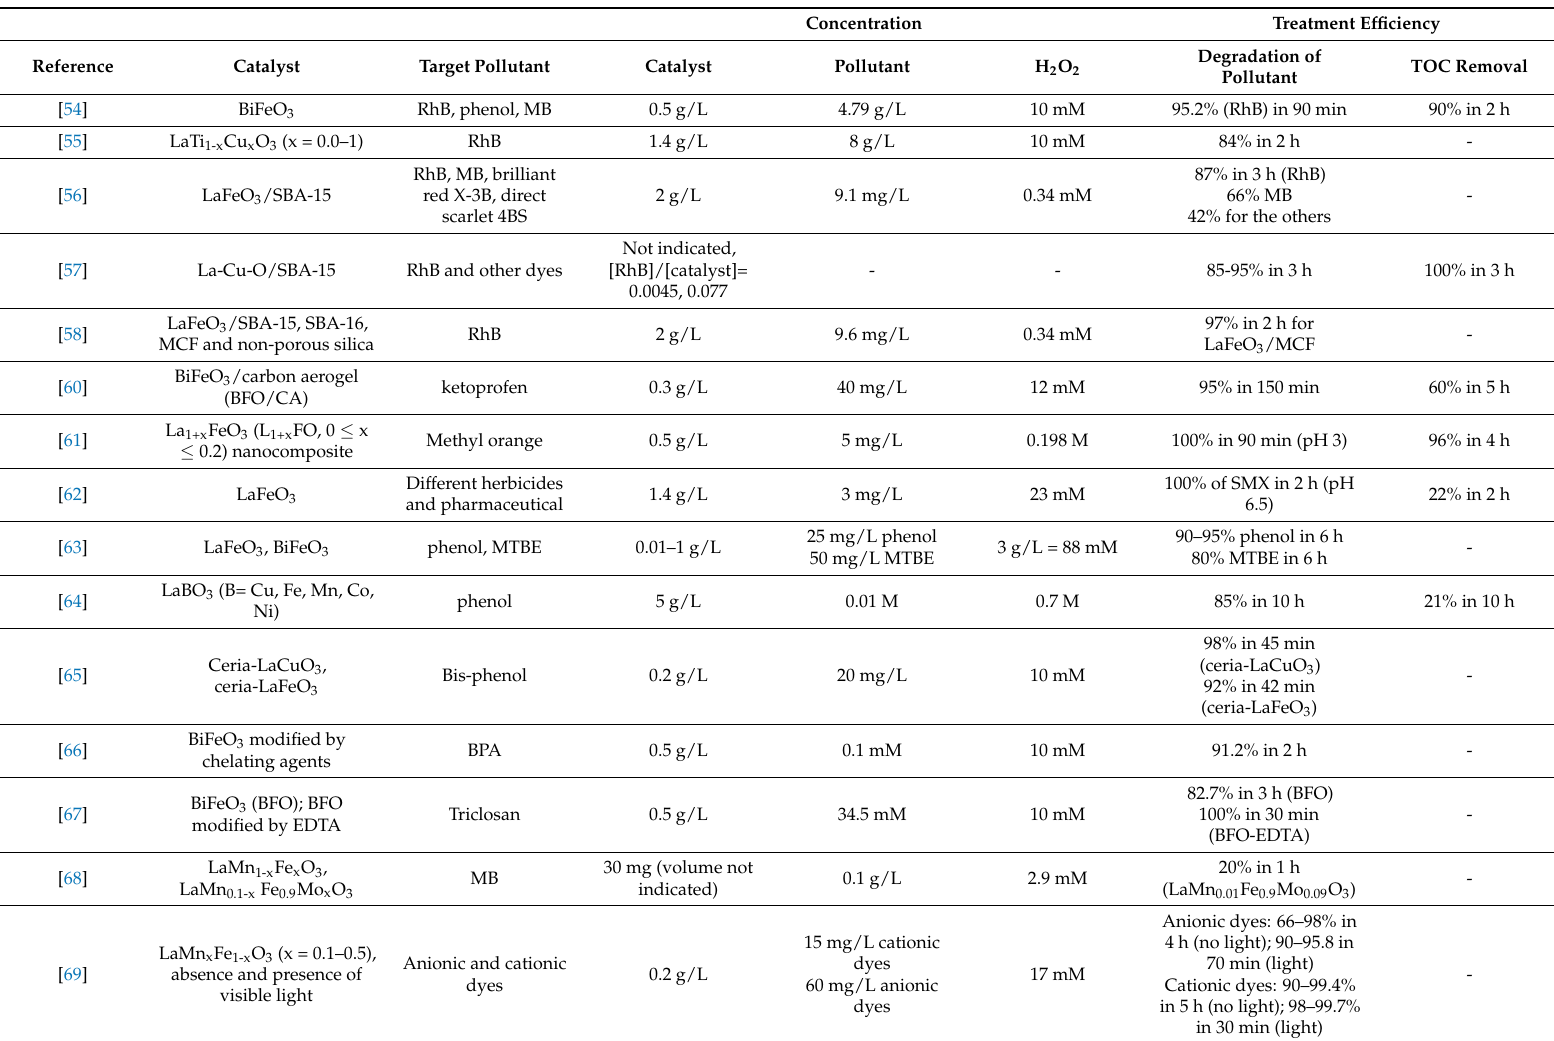
Table 1. Oxides type perovskite used in Fenton-like and photo Fenton-like reactions of organic pollutants in aqueous